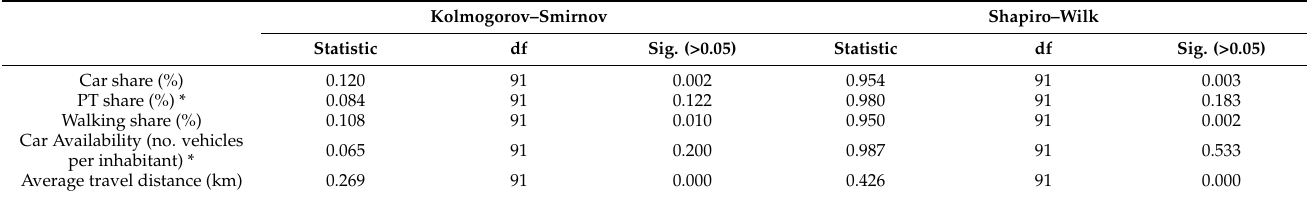
Table 4. Normality test results (of indicators proposed in Table